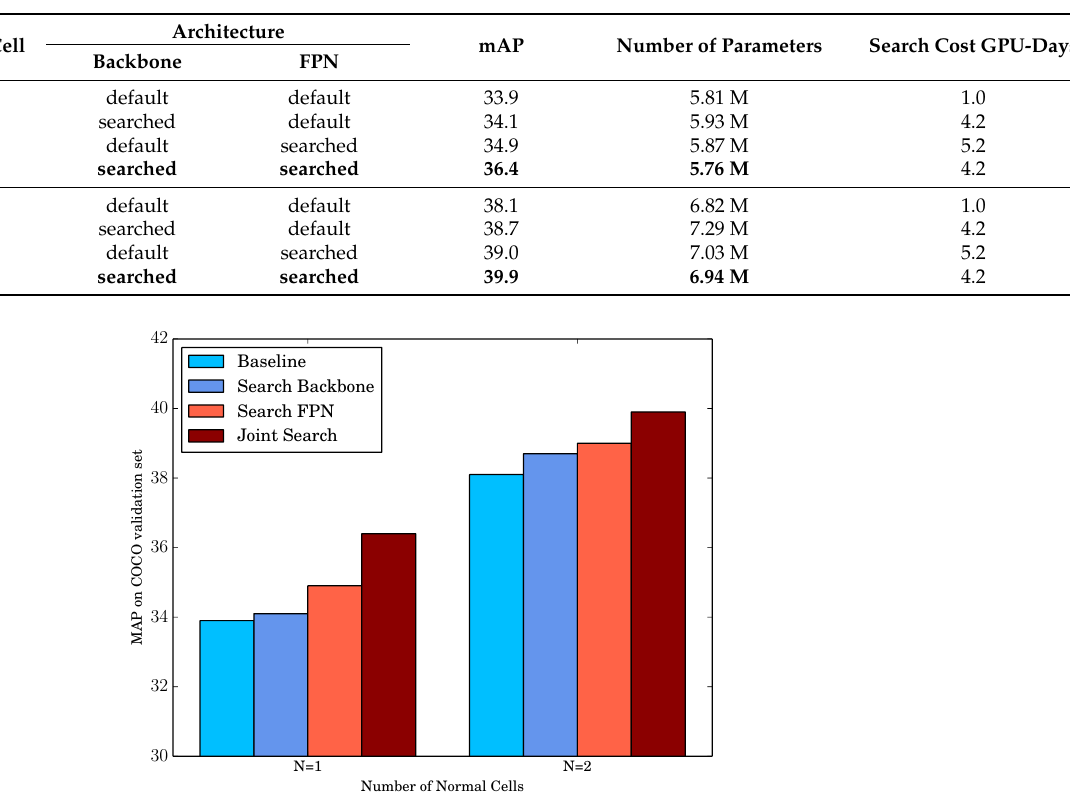
Table 1. Performance of joint and independent search for backbone and FPN on MS-COCO validation set. The default architecture of backbone is the architecture by DARTS [22]. The default architecture of FPN is the architecture of PANet [60]. Specifically, the ‘default’ backbone utilize the discovered architecture searched on classification task, which cost 1.0 GPU-day. Consequently, for the setting of ‘default’ backbone and ‘default’ FPN, the search cost is 1.0 GPU-day. For the setting of ‘default’ backbone and ‘searched’ FPN, the search cost is 5.2 GPU-day (1.0 GPU-day to search default backbone and 4.2 GPU-days to search FPN). The best setting and the corresponding performance among each block is in bold.